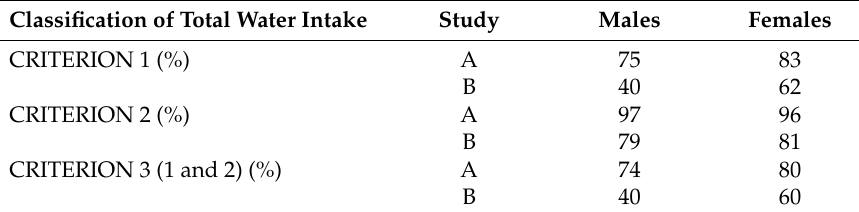
Table 9. Combined classification for the total water intake (TWI) following established